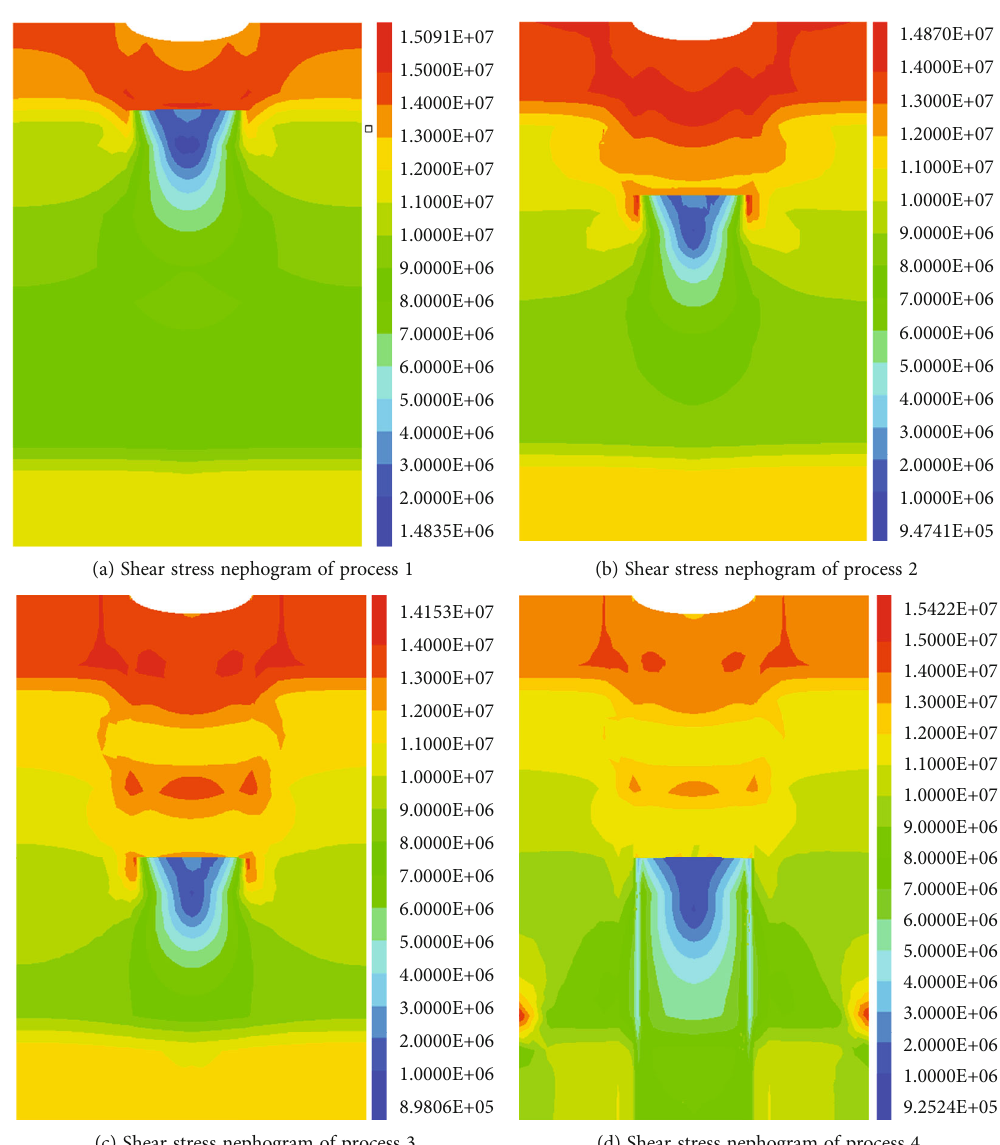
Figure 10: Maximum shear stress